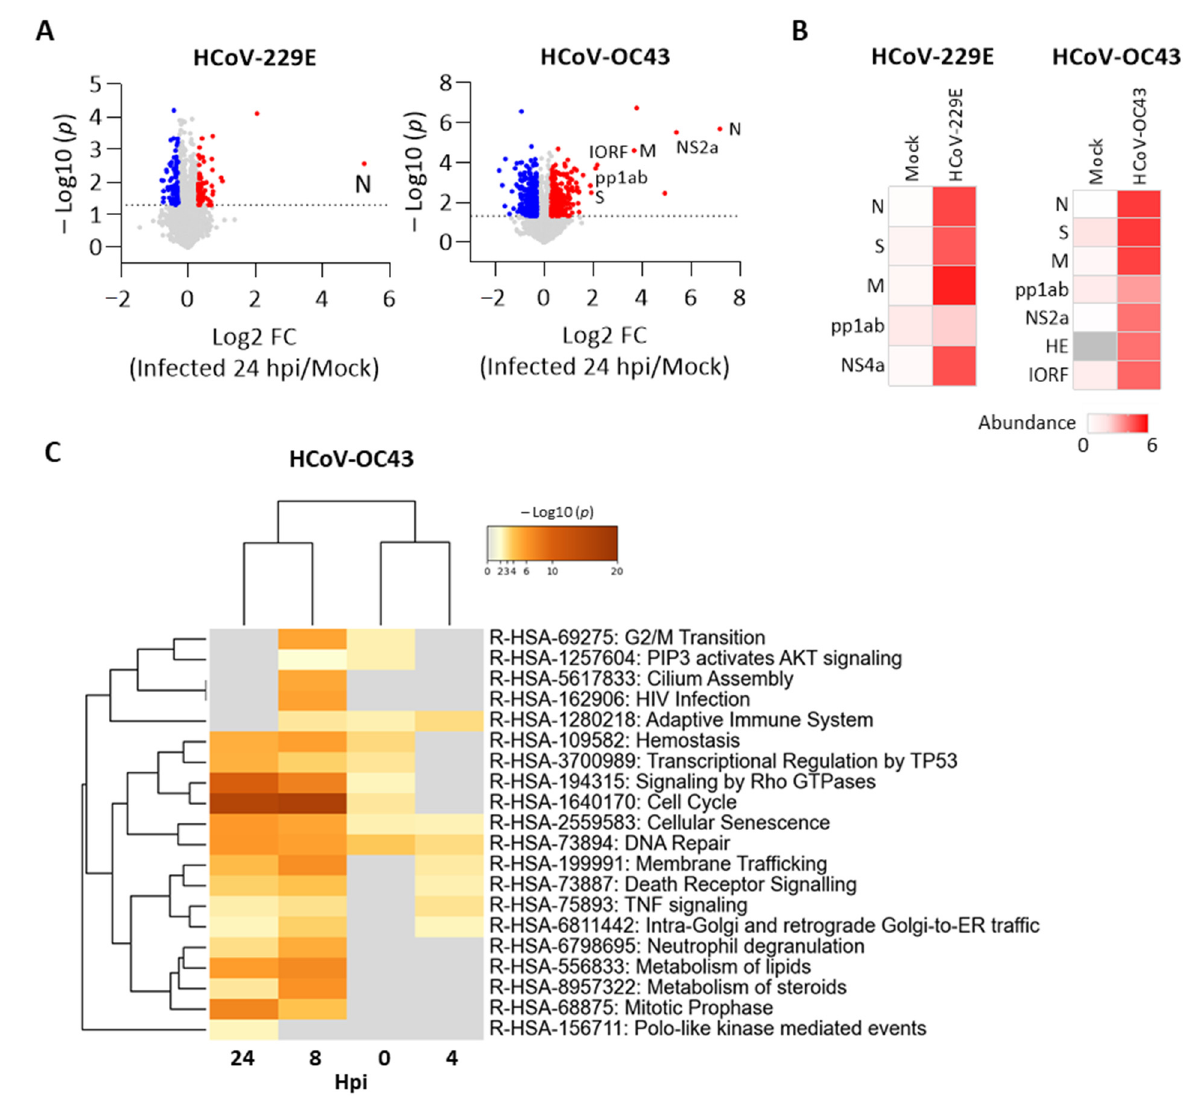
Figure 5. Cellular pathway changes in H1299 cells after HCoV-OC43 infection. Proteomic analysis of H1299 cells in response to HCoV-229E or HCoV-OC43 infection. ( A ) Volcano plots of the change in total protein levels comparing infected cells 24 hpi vs. mock infection. Up- (red) and down-regulated proteins (blue) with |log2 FC| > 0.3 and –log10 p value > 1.3 are highlighted. Detected viral proteins are labeled. ( B ) Protein abundance of all detected viral proteins across the infection time course. ( C ) Multi-list Reactome enrichment of DEPs (|log2 FC| > 0.3, p < 0.05) at each time point after HCoV-OC43 infection. Data present the top 20 statistically enriched Reactome pathway terms (–log10 p value > 1.3).